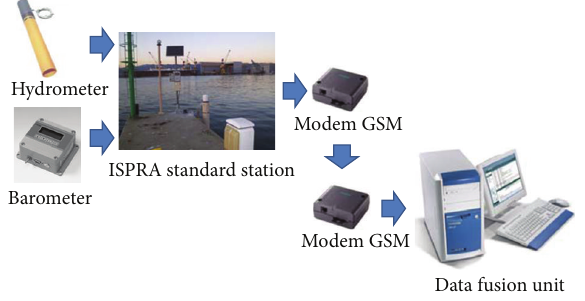
Figure 7: ISPRA standard meteomareographic station (La Spezia ISPRA station schematic).